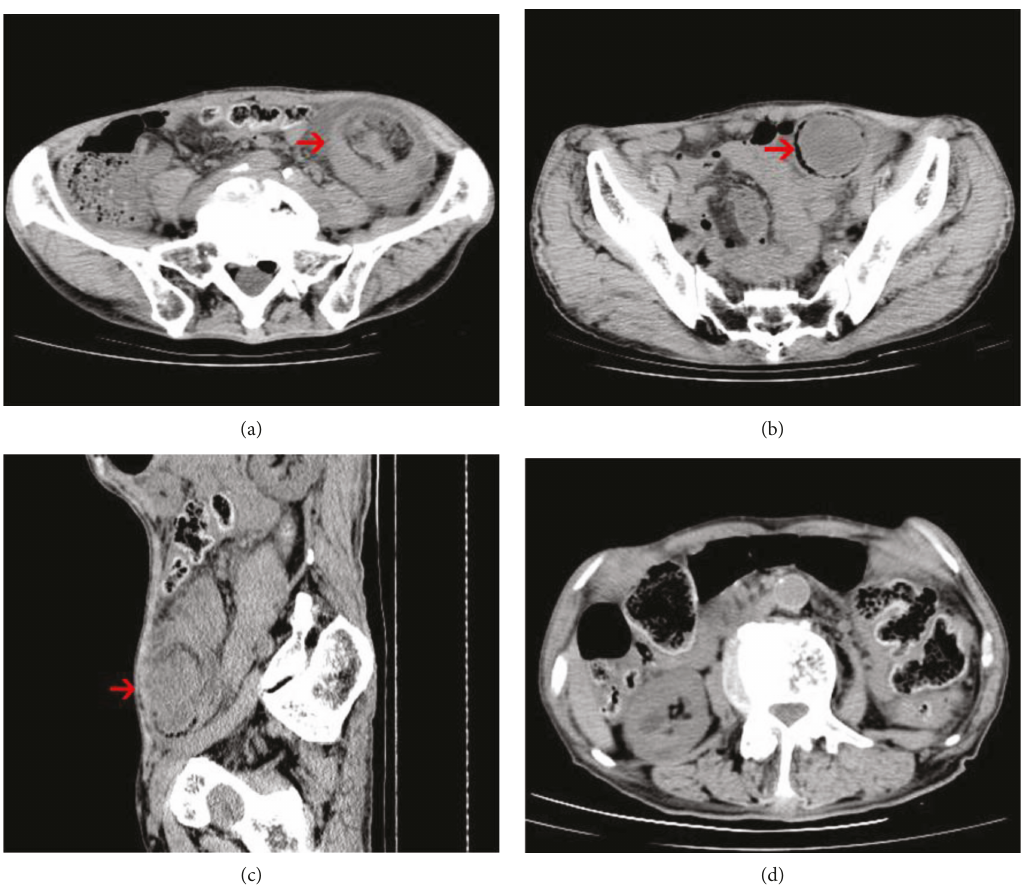
Figure 1: Abdominal CT of Case 1 showing (a) a target sign in the intestinal canal (arrow), (b) colonic schwannoma (arrow), (c) descending colon intussusception (arrow), and (d) intestinal obstruction caused by the